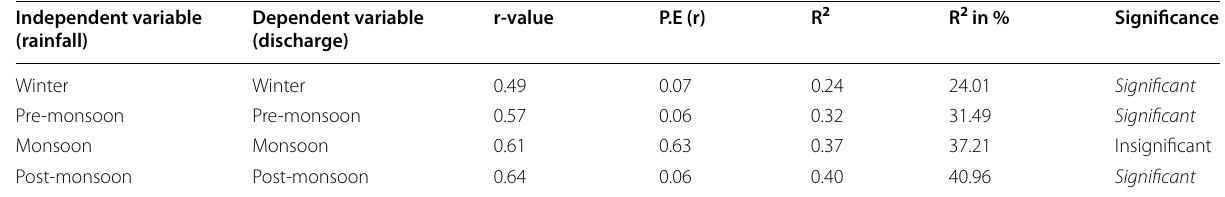
Table 6 Correlation between seasonal mean discharge and mean rainfall from 1973 to 16 Independent variable